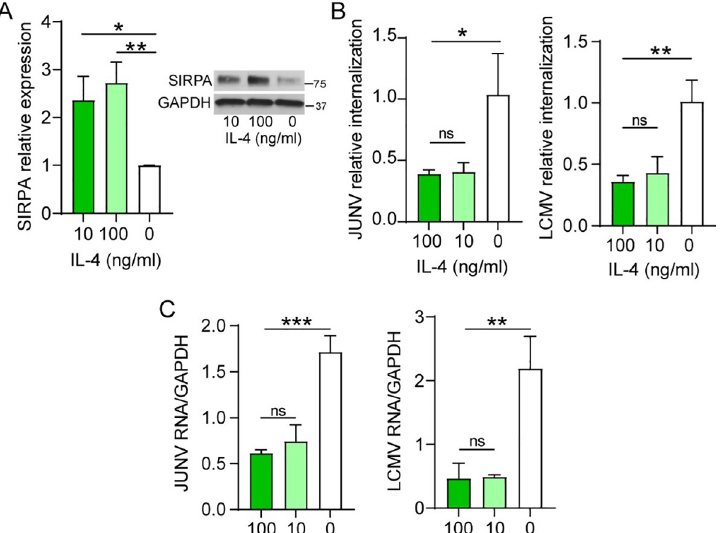
Fig 7. Interluekin-4 (IL-4) treatment upregulates SIRPA expression and decreases viral internalization. A) U2OS cells were pre-treated with the indicated concentrations of IL-4 for 48 hr and SIRPA expression levels were quantified by western blot. The MW of human SIRPA is 85kD. Shown is the average ± SD of 3 independent experiments. One- way ANOVA was used to determine significance. �� , P � 0.003. B) and C) U2OS cells were pre-treated with IL-4 and were subjected to VIAs (B) and infection for 24 hr. (C) with JUNV-C1 and LCMV. Shown is the average ± SD of 3–4 independent experiments. One-way ANOVA was used to determine significance. � , P � 0.02; �� , P � 0.002; ��� , P �